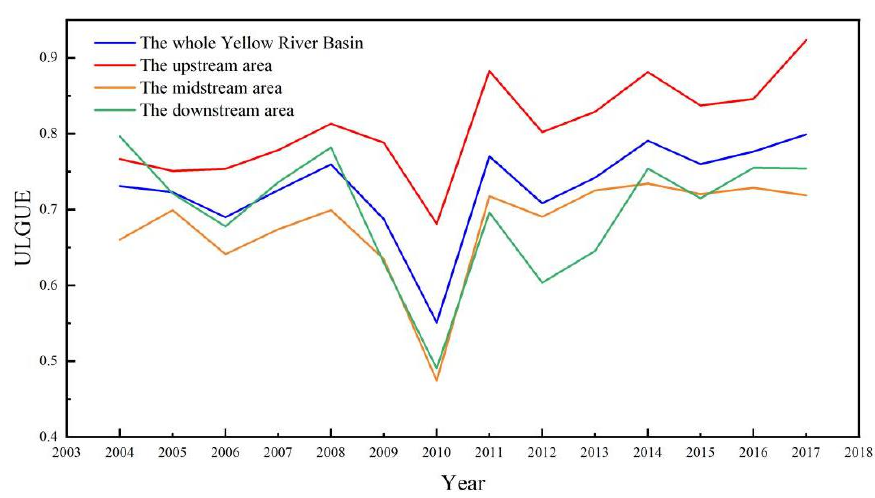
Figure 3. Average values of ULGUE of different areas in the YRB from 2004 to 2017.